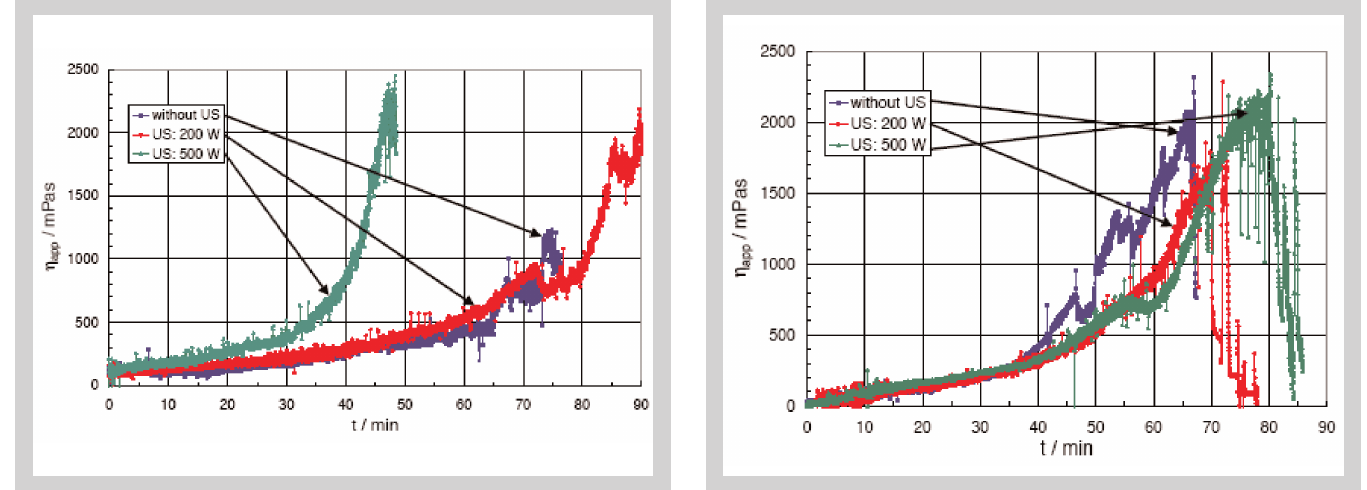
Figure 3: Apparent viscosity for (a) F = 56.5 % (left), (b) F = 60.1 %. (V· = 4 l/min, Pmax = 0, 200 and 500